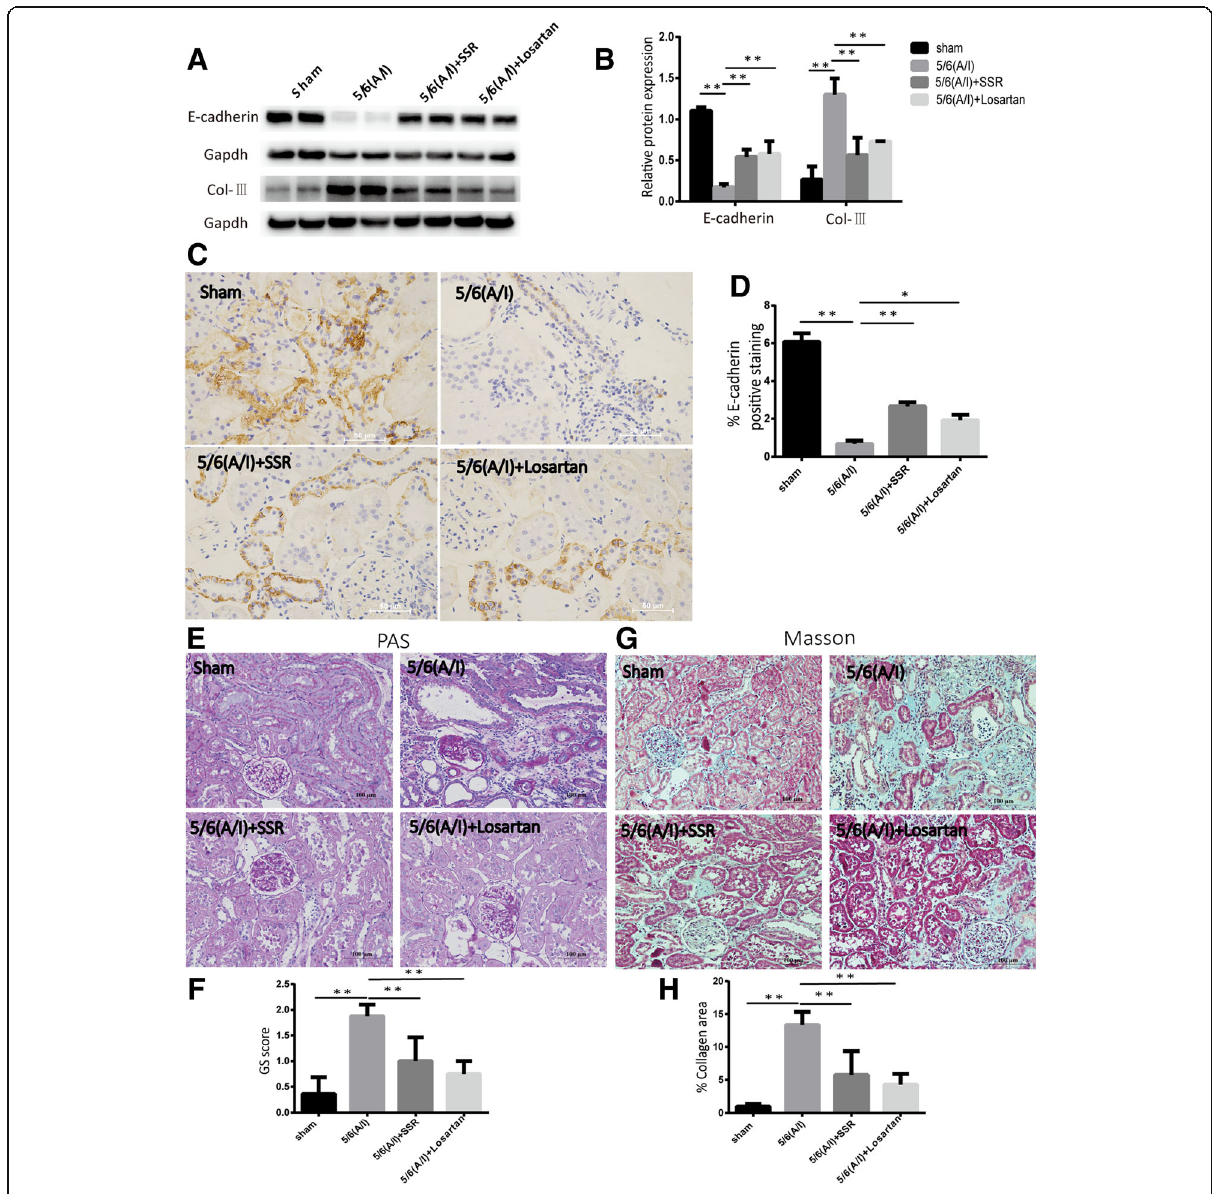
Fig. 1 SSR attenuated renal injury and fibrosis in 5/6(A/I) model. ( a ) Immunoblot analysis of E-cadherin and Col-IIIexpression. ( b ) Western blot quantification of E-cadherin and Col-III levels.( n = 6) ( c ) Representative images of E-cadherin expression detected by IHC. 400 × magnification. ( d ) Quantitative analysis of E-cadherin positive area( n = 4) ( e ) Representative photomicrographs of PAS staining. 200 × magnification. ( f ) The severity of glomerular injury was assessed using the glomerulosclerosis (GS) score ( g ) Assessment of interstitial fibrosis by Masson ’ s trichrome staining.200 × magnification. ( h ) Semiquantitative result of collagen area(n = 4). Values are mean ± SD. * P < 0.05, ** P <